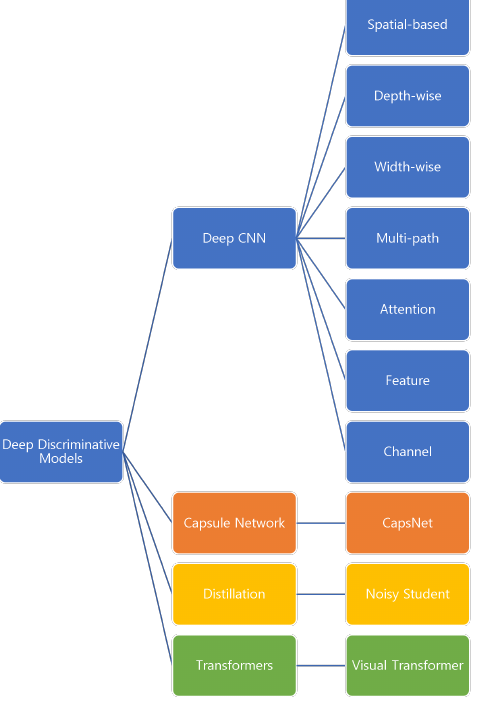
Figure 4. Classification of deep learning discriminative models based on their architecture, extending [80], where Deep CNN is the most studied topic for T2Vo tasks and is further